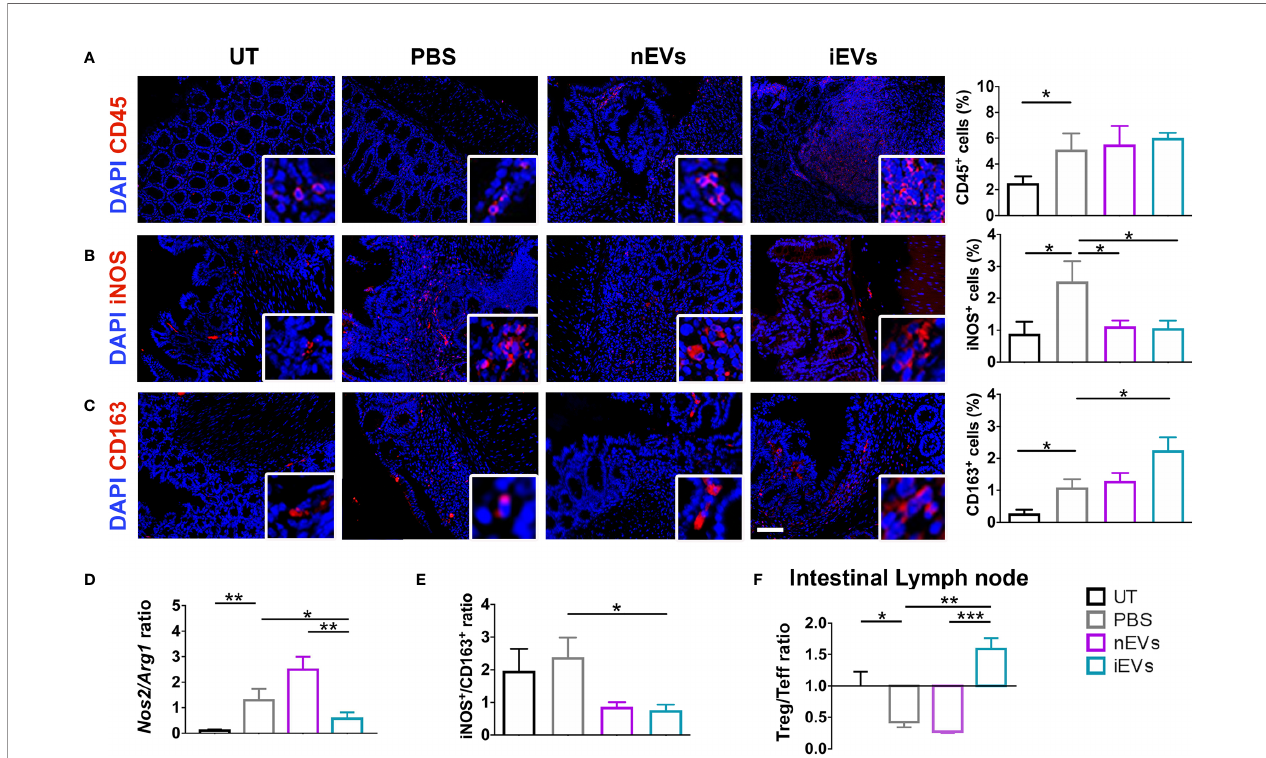
FIGURE 5 | EV administration reverts macrophage polarization to an anti-in fl ammatory phenotype and improves M1/M2 and Treg/Teff ratio. (A) CD45 pan lymphocyte IF. CD45 positive cells are equally present in PBS, nEVs and iEVs treated mice. (B, C) Immuno fl uorescence labeling of macrophage polarization markers in colon mucosa: IF (left), quanti fi cation (right). iEVs induce CD163 protein, M2 marker. (D) qRT-PCR M1/M2 ratio: iEV administration results in a signi fi cant presence of anti-in fl ammatory Arg1 gene. (E) protein M1/M2 ratio. (F) Cyto fl uorimetric analyses of freshly isolated cells form intestinal lymph node: Treg/Teff ratio. Scale bar: 50 m m. Results are mean ± standard error (n = 5). *P < 0.05, **P < 0.01, ***P <